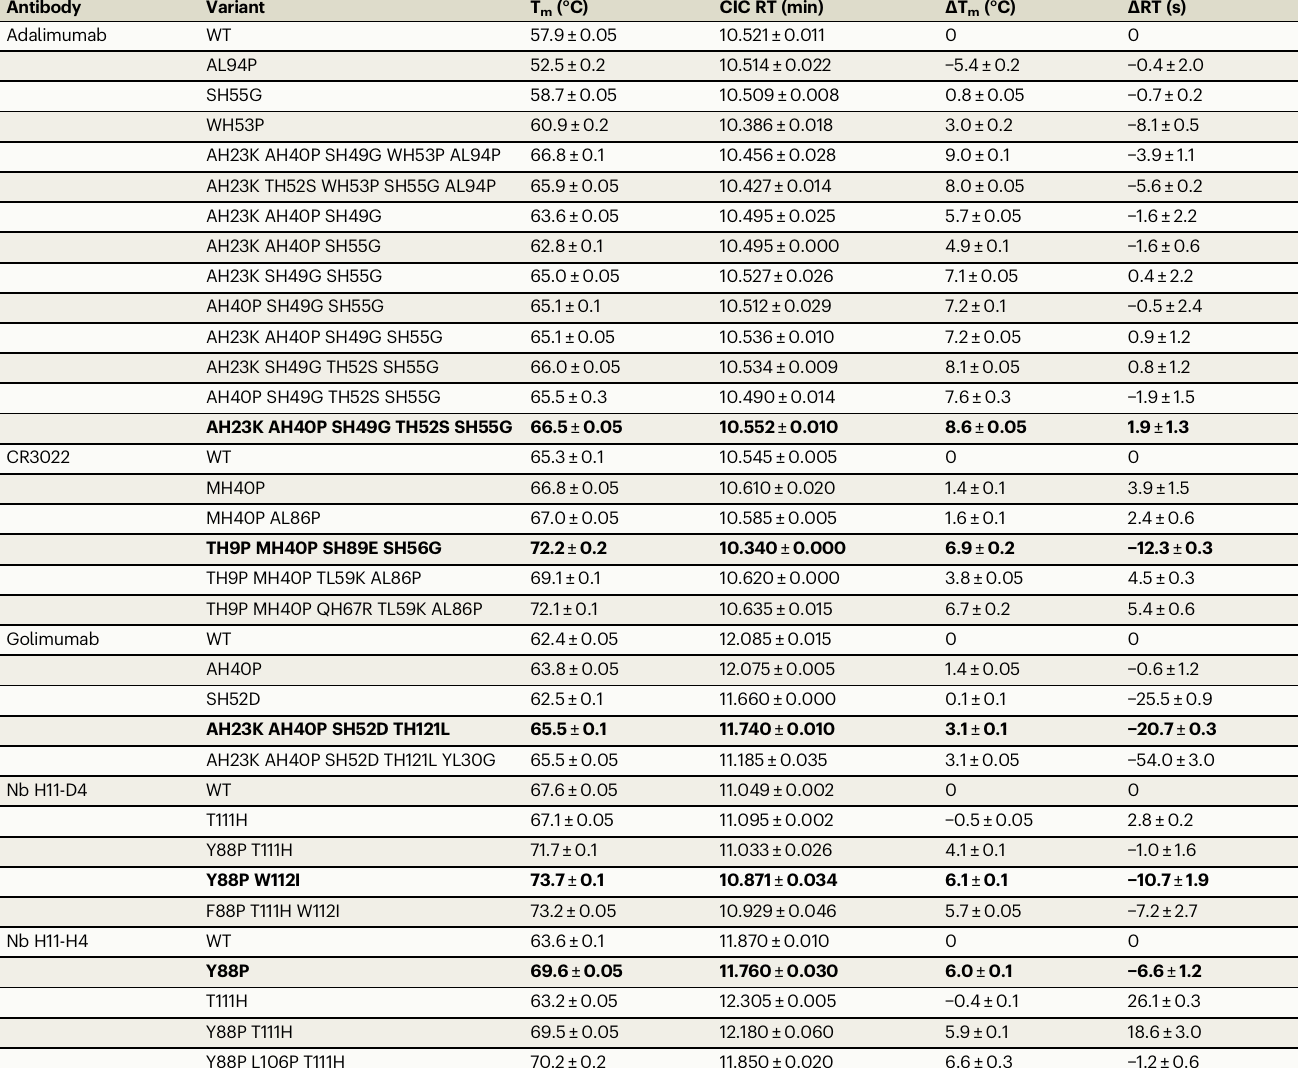
Table 2 | Experimentally characterised designed antibody variants